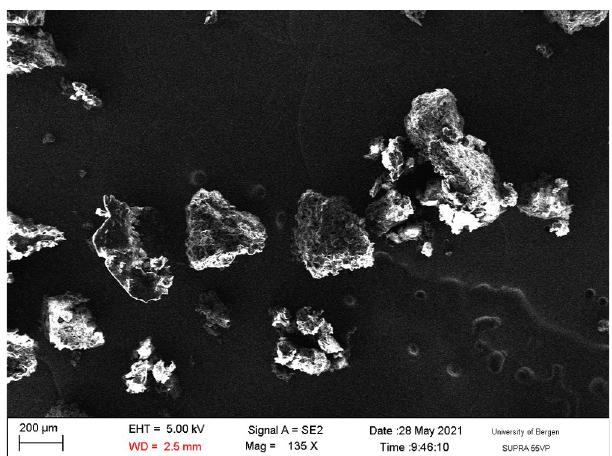
Figure 2. Scanning electron microscopy image of the dry coffee particles.